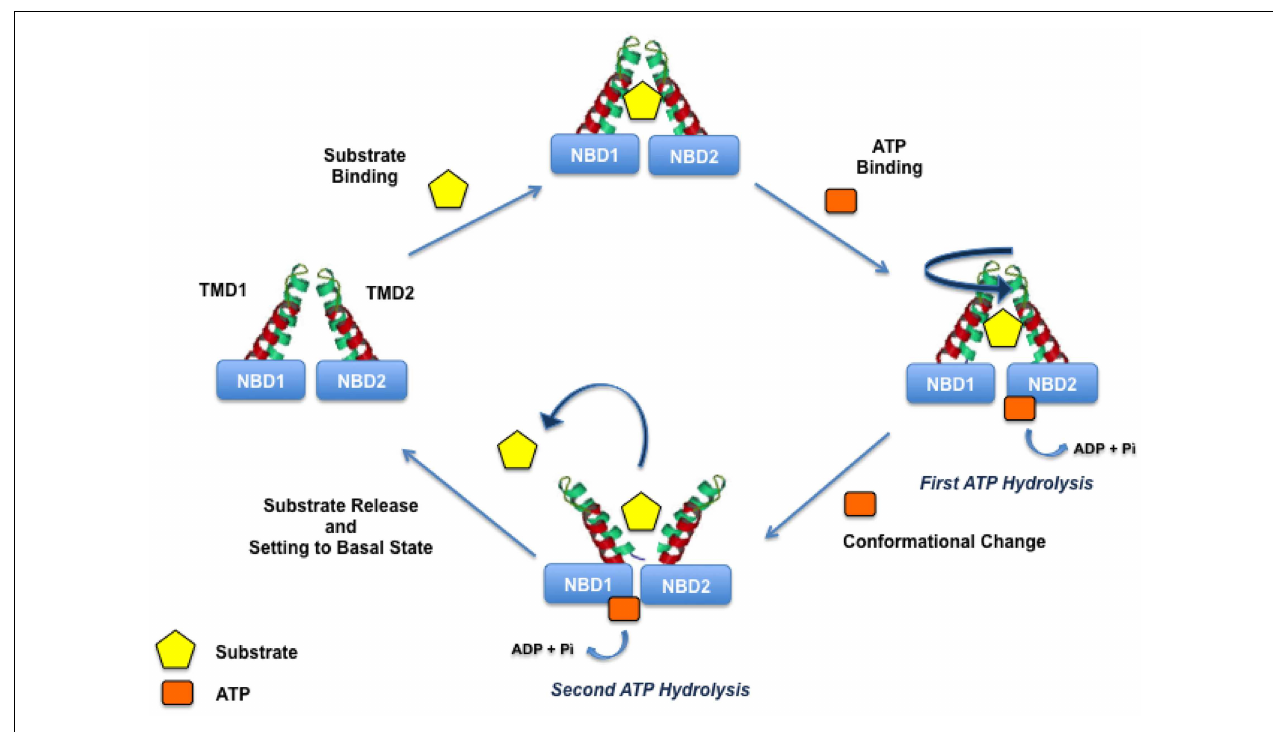
FIGURE 3 | P-gp translocation mechanism